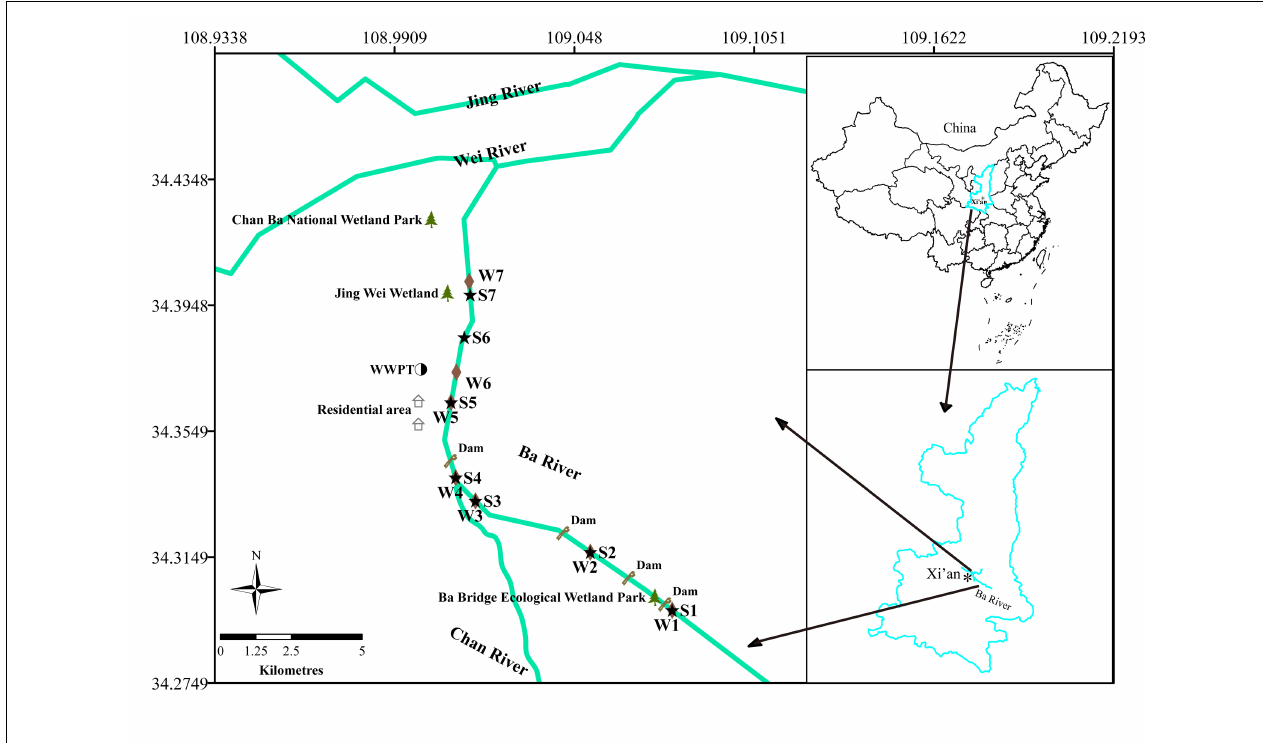
FIGURE 1 | Map of the study area and the sampling sites.